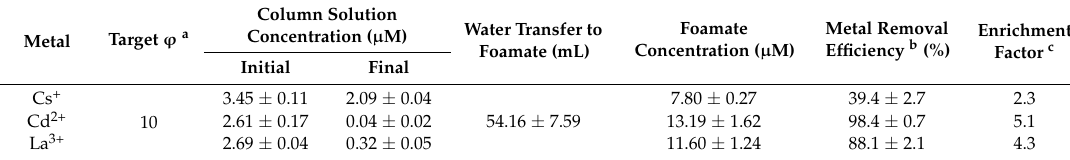
Table 2. Results of ion flotation for mixed metal solutions of Cs + , Cd 2+ , and La 3+ in triplicate columns (n = 3). Column conditions: 250 mL volume, pH 7.0 ± 0.1, 50 mL min −1 airflow, 100 µM monorhamnolipid, 0.5% ( v / v ) ethanol.